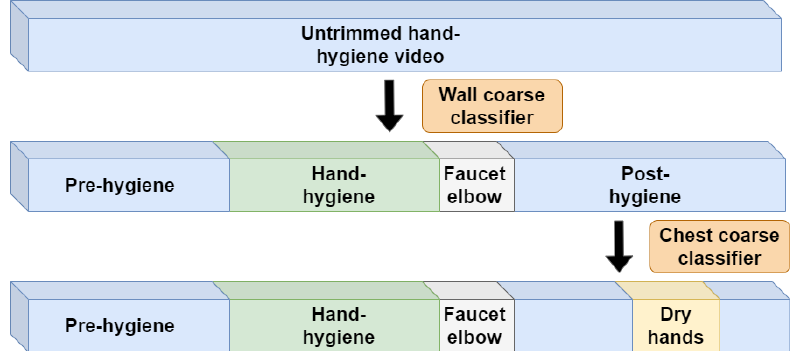
Figure 6. System stage 1: Untrimmed hand-hygiene video processing with coarse